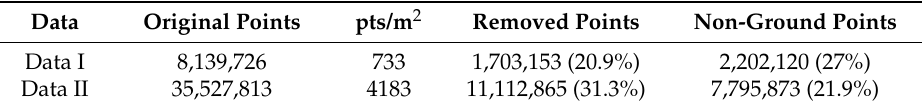
Table 1. Mobile Laser Scanning (MLS) Point cloud information.